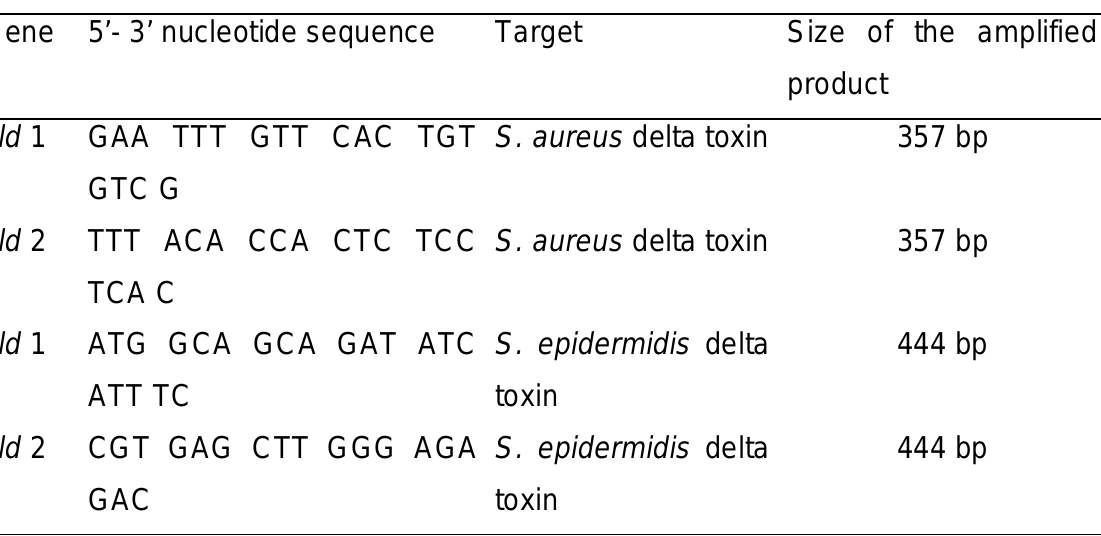
Table 1. Primers used for the detection of the delta toxin